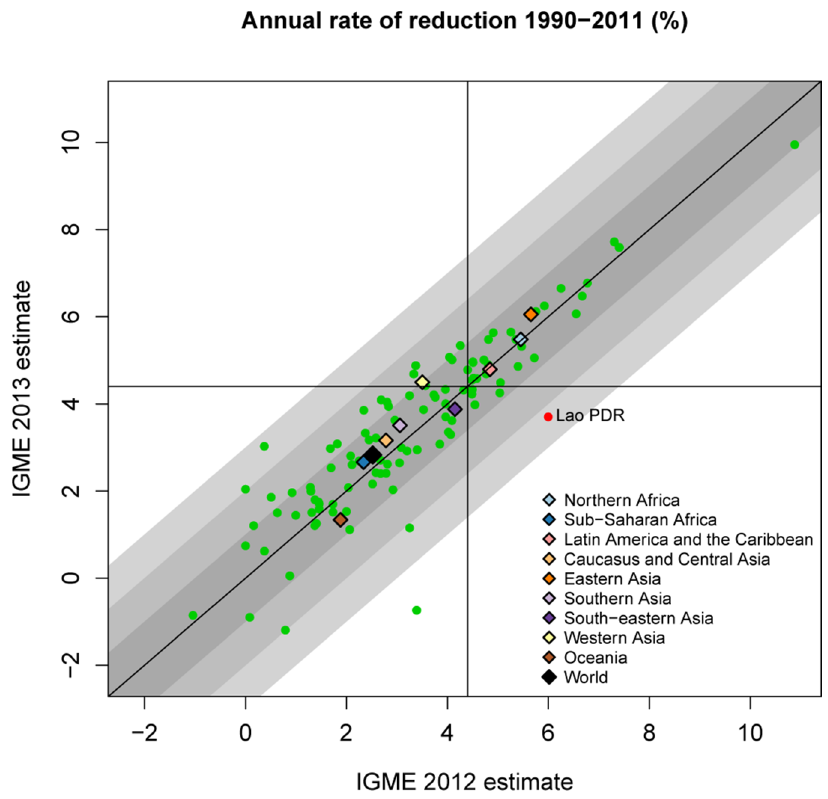
Figure 3. UN IGME 2013 and UN IGME 2012 estimates of the annual rate of reduction for 1990–2011. UN IGME 2013 estimates are plotted against UN IGME 2012 estimates. Gray areas represent absolute differences of up to 1%, 2% and 3% respectively (absolute difference). Country-specific ARR estimates are plotted in green for high mortality countries (with U5MR in 1990 of at least 40 deaths per 1,000 live births), or in red for a subset of these if the difference is at least 2% and the UN IGME 2013 and UN IGME 2012 estimates disagree with respect to whether the country is on track to meet MDG 4 (4.4% annual rate of reduction). Regions are colored according to the given legend.